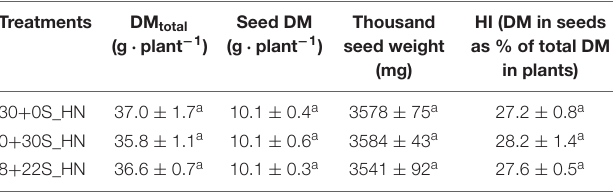
TABLE 4 | Total DM (g · plant − 1 ), seed DM (g · plant − 1 ), thousand seed weight (mg), and the HI (DM in seeds as % of total DM in plant) for plants grown under 30 + 0S_HN, 0 + 30S_HN, and 8 + 22S_HN conditions. Treatments